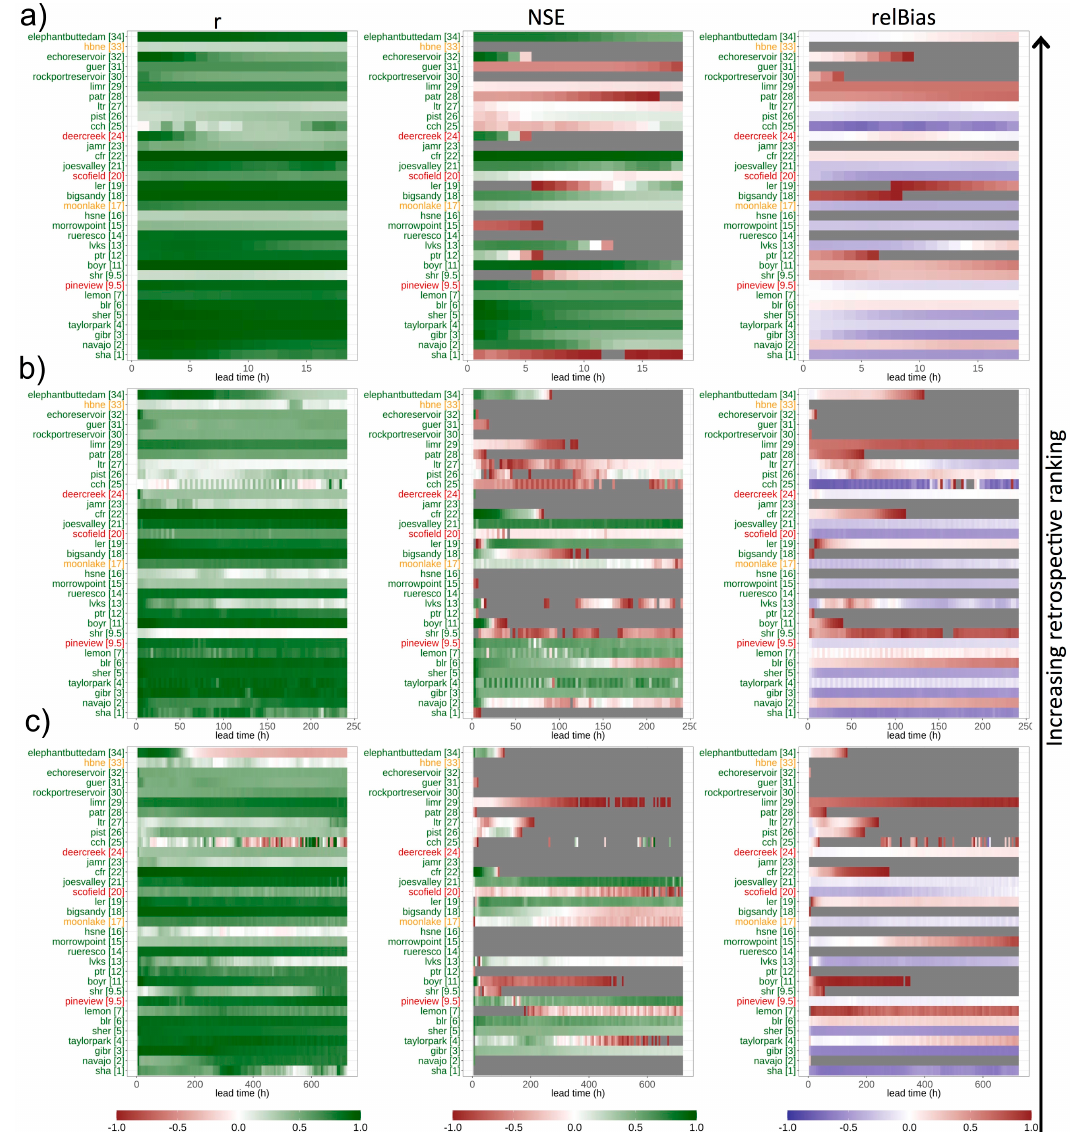
Figure 7. Performance of NWM reservoir inflows across lead times for one year, where reservoirs in each subplot are ordered from bottom to top by the retrospective ranking (best to worst, listed in parenthesis on the y -axis with reservoir name). Each column from left to right columns illustrate r , NSE, relBias , where the metric is scaled by color density and grey is out of valid range. The subplot rows are forecast cycles: short ( a ), medium ( b ), long( c ).